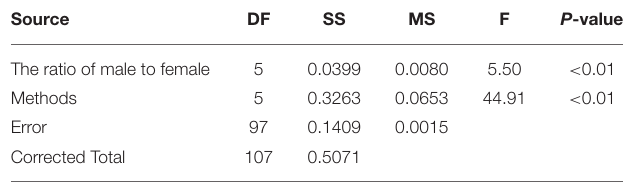
TABLE 7 | Variance analysis of the ratio of male to female on the accuracy of GEBV for fiber diameter. Source DF